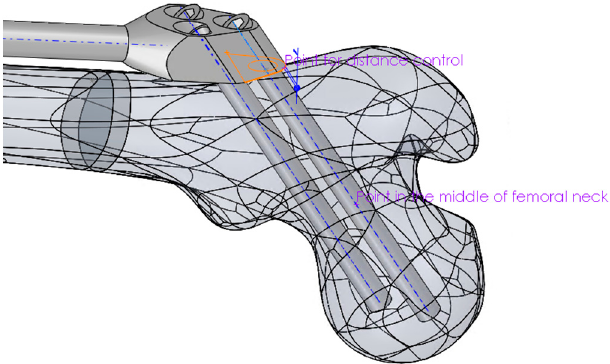
Figure 4. Positioning of the proximal part of the trochanteric unit relative to the femur.